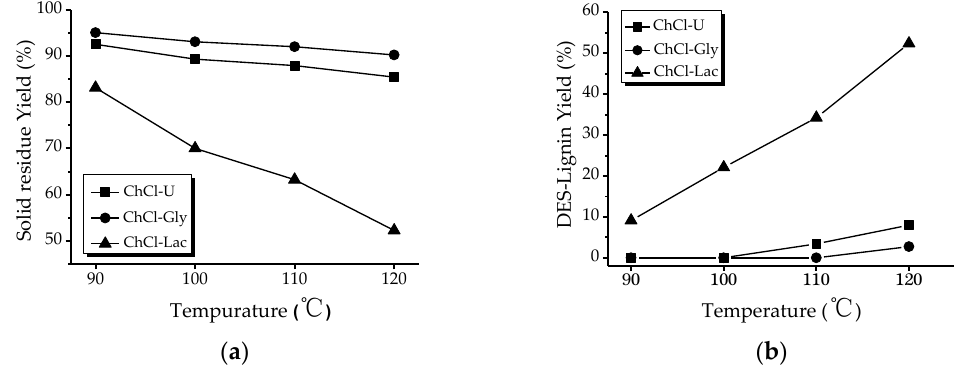
Figure 1. Effect of deep eutectic solvents (DESs) type and temperature on the solid residue yield ( a ) and DES-lignin yield ( b ) (molar ratio of choline chloride (ChCl) to hydrogen-bond donors (HBD) was 1:2, and the treatment time was 6 h).